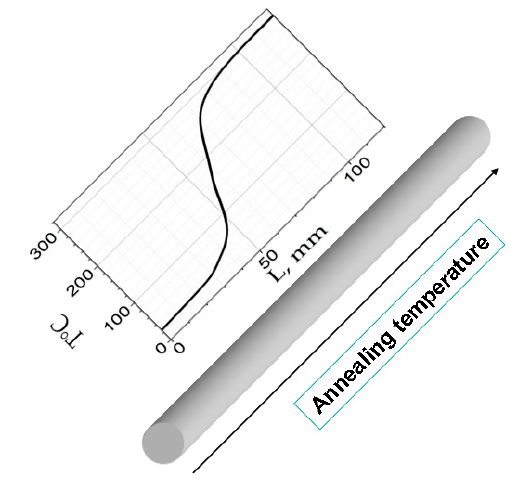
Figure 2. Distribution of annealing temperature T ann in sample.